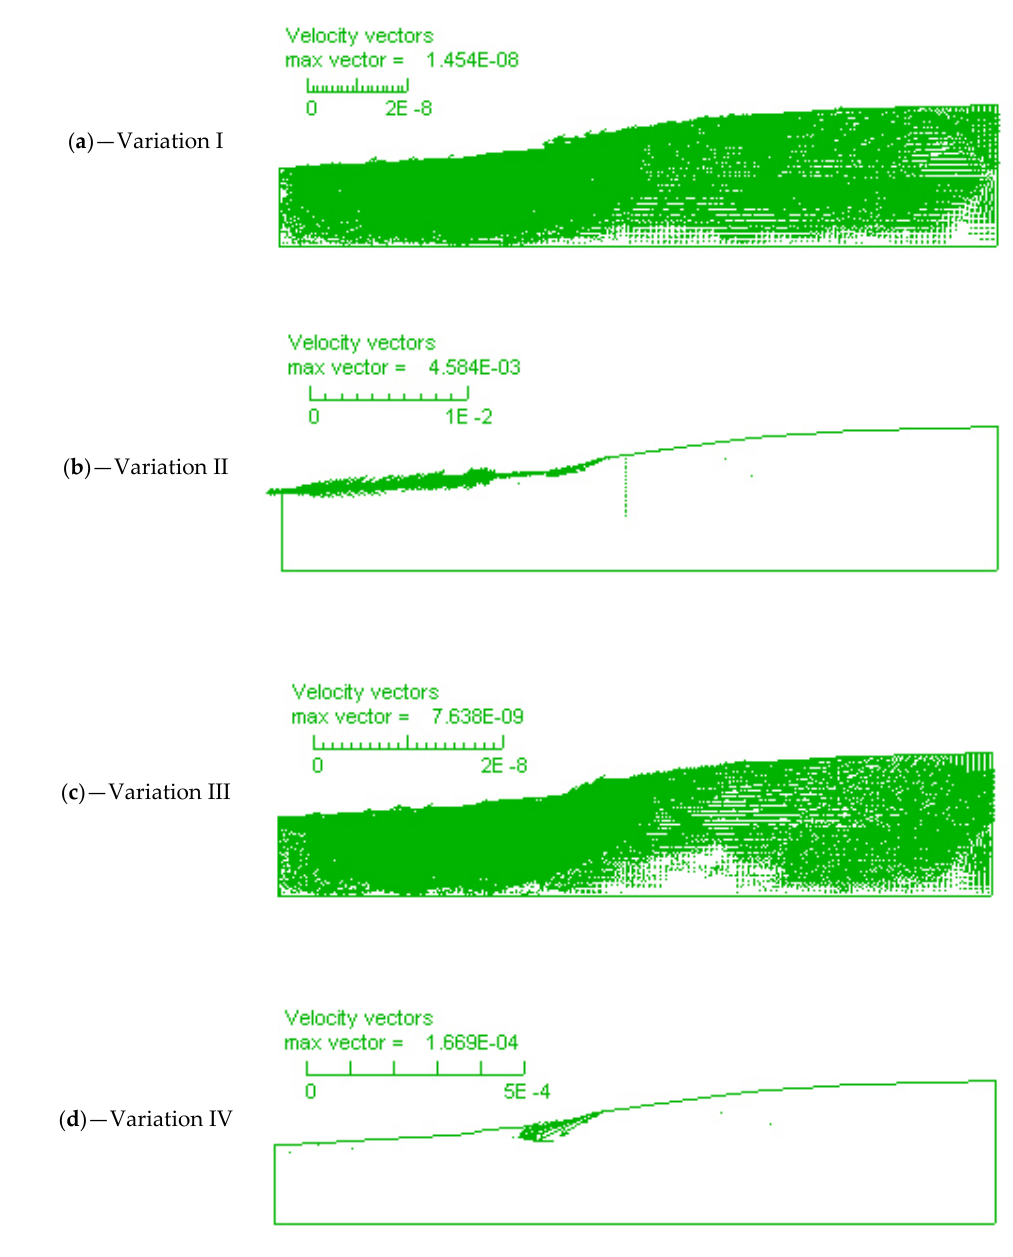
Figure 7. Maps of velocity vectors.